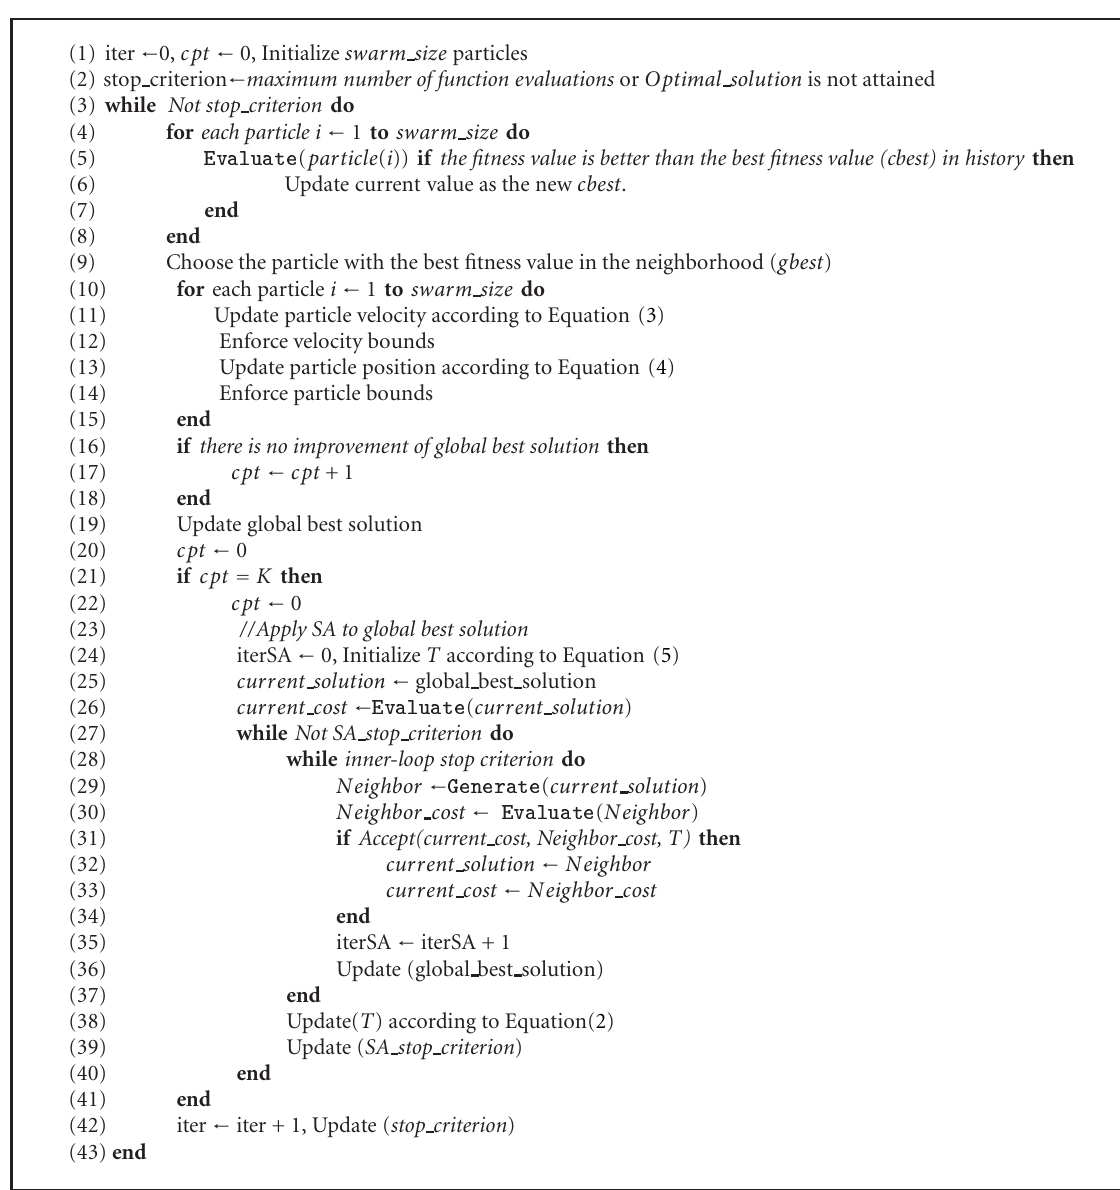
Algorithm 1: HPSO-SA hybrid